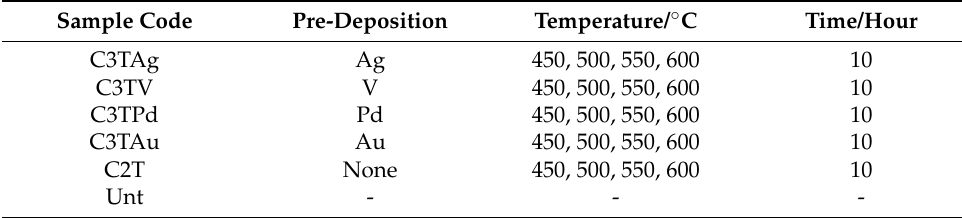
Table 2. Treatment conditions and sample